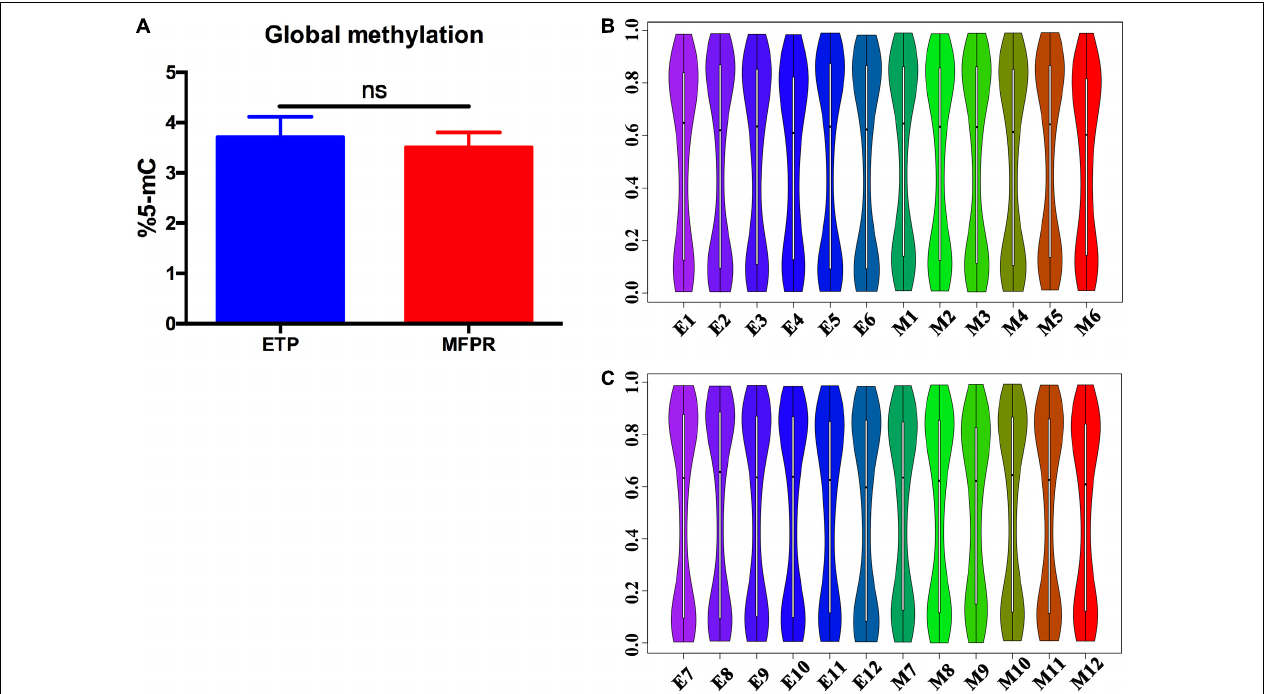
FIGURE 1 | Percentage of global DNA methylation and violin plots for the overall distribution of different methylation levels in the ETP and MFPR groups. (A) Global DNA methylation in ETP controls ( n = 12) and MFPR group ( n = 12). Data are presented as mean ± SE. (B,C) Violin plots of the overall distribution of different methylation levels. The abscissa represents different samples, the ordinate represents the level of methylation of samples, and the width of each violin represents the density of the point at that methylation level. The boxplot shows the methylation levels in each violin, and the black dots represent the mean levels of methylation of the samples. (B) The overall distribution of different methylation levels in ETP male controls (left 6 violin plots labeled as E1–E6) and the MFPR male group (right 6 violin plots labeled as M1–M6). (C) The overall distribution of different methylation levels in ETP female (left 6 violin plots labeled as E7–E12) controls and the MFPR female group (right 6 violin plots labeled as